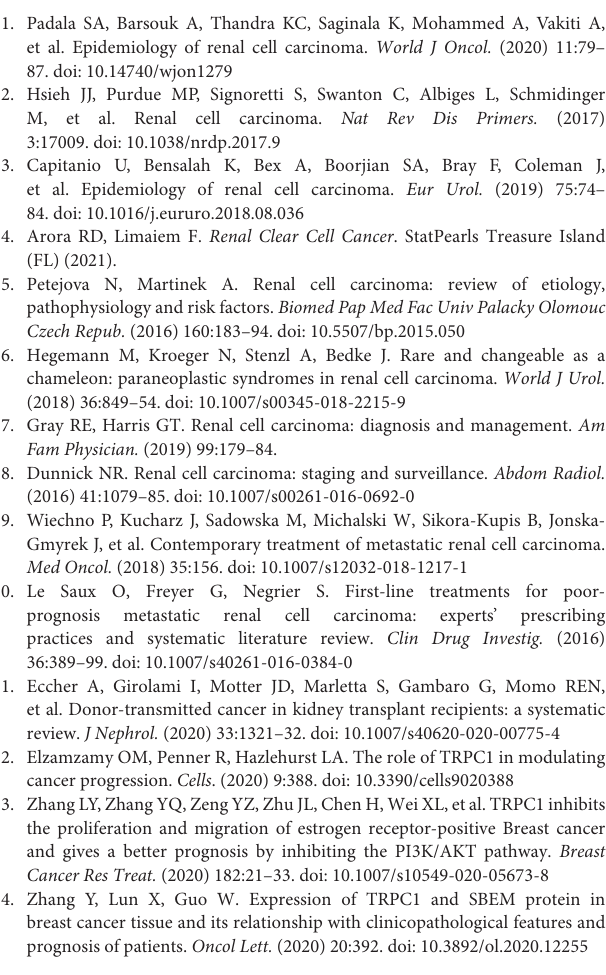
Supplementary Figure 1 | Correlation between transient receptor potential channel (TRPC1) mRNA level and TRPC1 protein expression. Correlation between TRPC1 mRNA expression and TRPC1 immunohistochemistry (IHC) score in tumor tissues (A) and adjacent tissues (B) . TRPC1, transient receptor potential channel 1; IHC, immunohistochemistry; mRNA, messenger